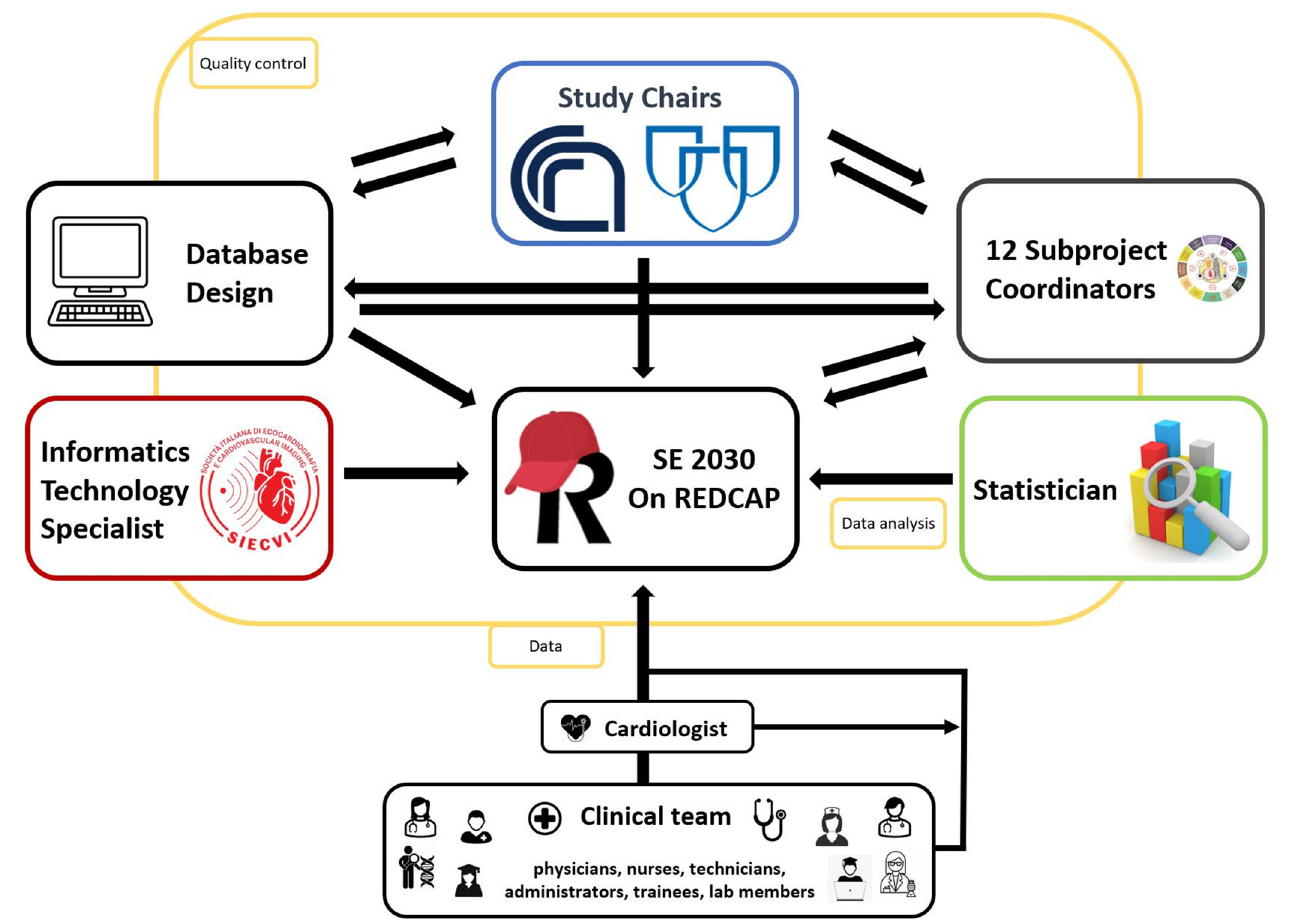
Figure 3. Schematic representation of the workflow methodology for building a REDCap database for the SE2030 study: data access, logistics, and sharing.